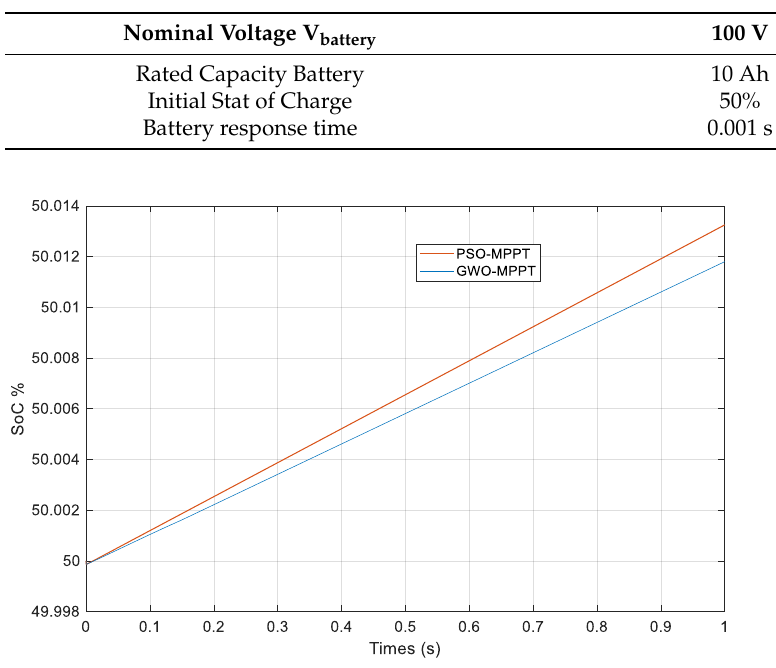
Figure 14. SoC using the PSO MPPT and GWO MPPT.